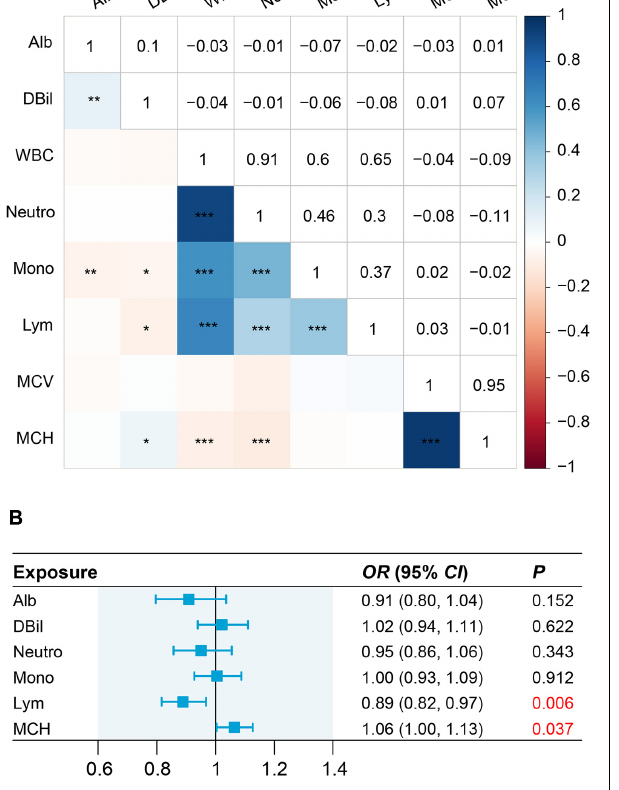
FIGURE 3 | Genetic correlation for eight risk factors and causal effects on severe COVID-19 estimated by multivariable MR analysis. (A) Pair-wise genetic correlations with significance at P < 0.05, P < 0.01, and P < 0.001 are marked with a single asterisk (*), double asterisk (**), and triple asterisk (***), respectively. (B) In multivariable MR analysis, we exclude white blood cell and mean corpuscular volume from this analysis because white blood cell is highly correlated with neutrophil count ( r g = 0.91, P < 0.001) while mean corpuscular volume is highly correlated with mean corpuscular hemoglobin ( r g = 0.95, P <